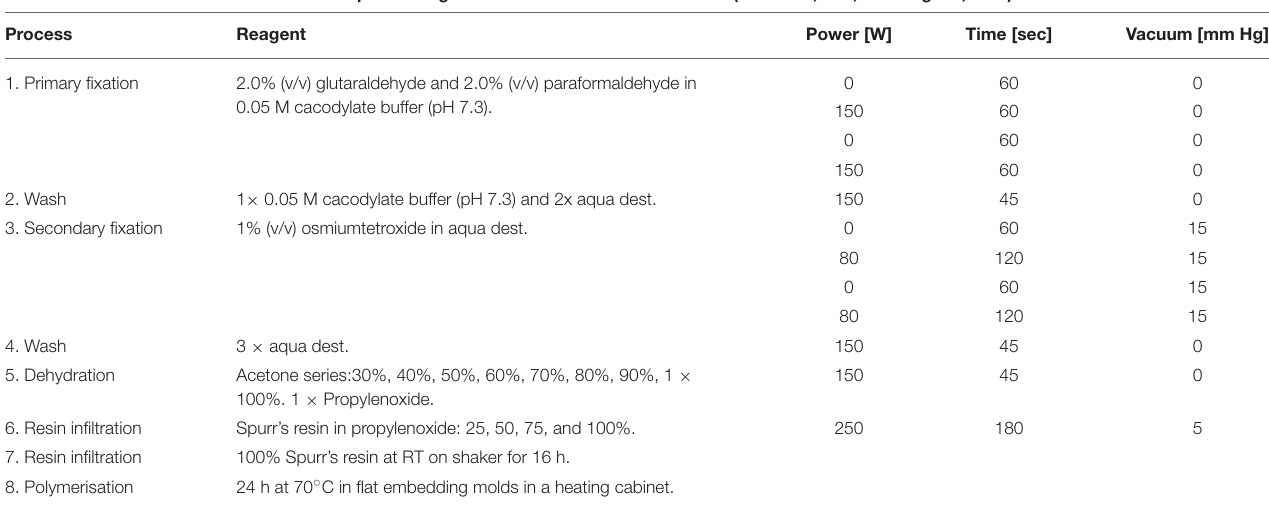
TABLE 1 | Sample preparation for transmission electron